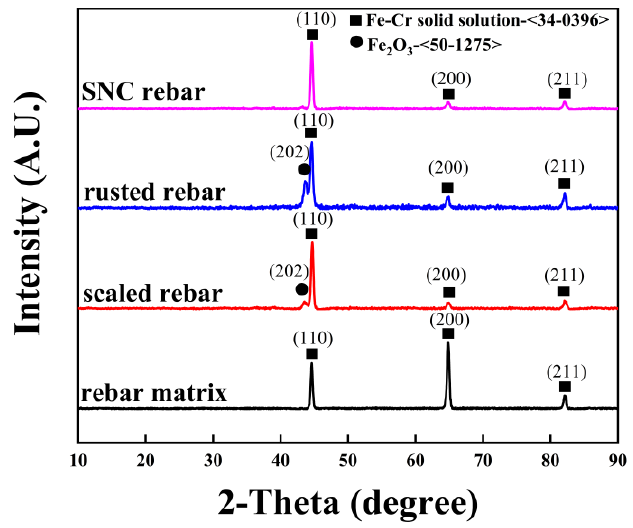
Figure 3. XRD patterns of rebar with different surface conditions.